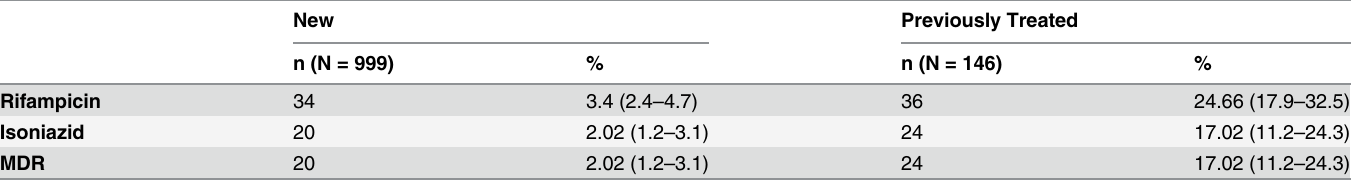
Table 1. Proportions of resistance to rifampicin isoniazid and MDR in new and previously treated TB cases in 4 provinces in PNG from Oct 2012 to Dec